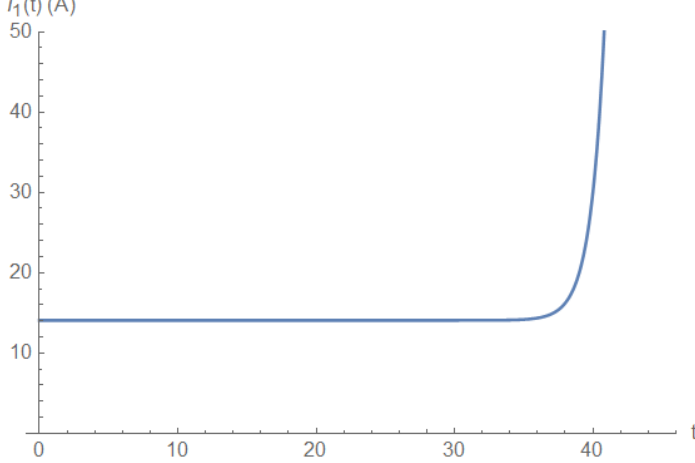
Figure A5. Source current before the short.